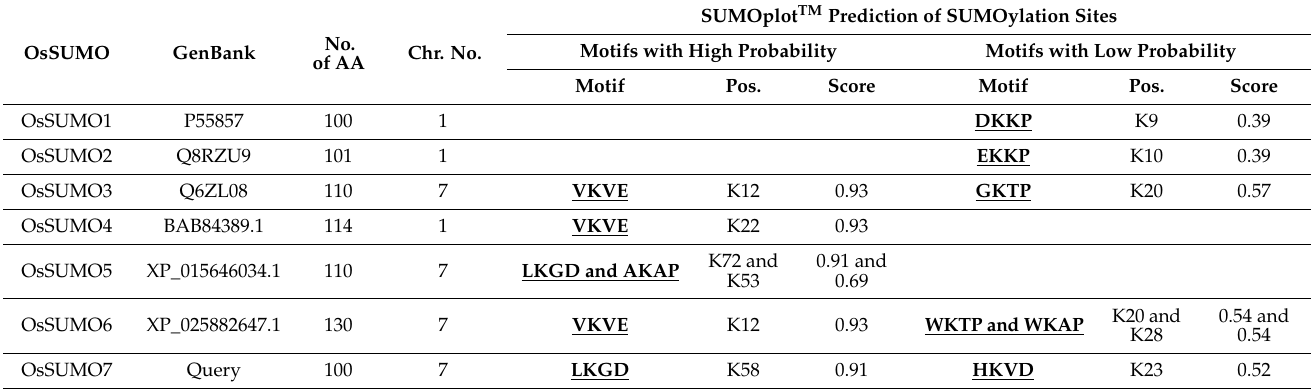
Table 1. Putative protein characterization of identified rice SUMO genes.